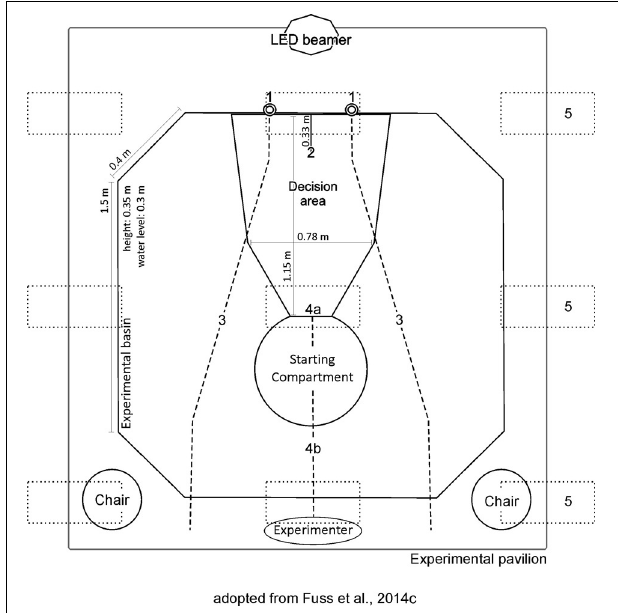
FIGURE 1 | The experimental setup located within the experimental basin, inside the white pavilion. The keyhole-shaped setup consisted of a Starting Compartment, a decision area and a frosted screen for projections, featuring a divider allowing for unambiguous choice-making (left and right). For the projections, a LED beamer was used. Sharks were placed within the SC at the start of each trial. 1 = feeders, 2 = frosted screen for projection, 3 = cable pulls to release feeders, 4a = guillotine door, 4b = cable pull to open guillotine door, 5 = ceiling mounted fluorescent tubes (above pavilion